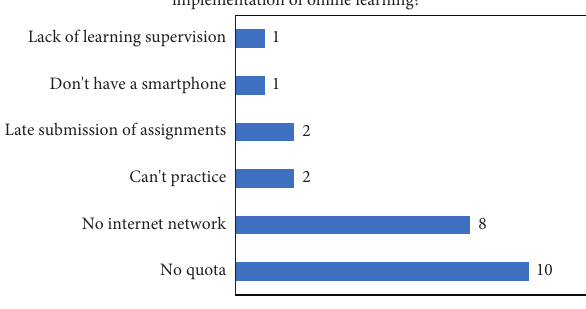
Figure 2: The online learning problem.